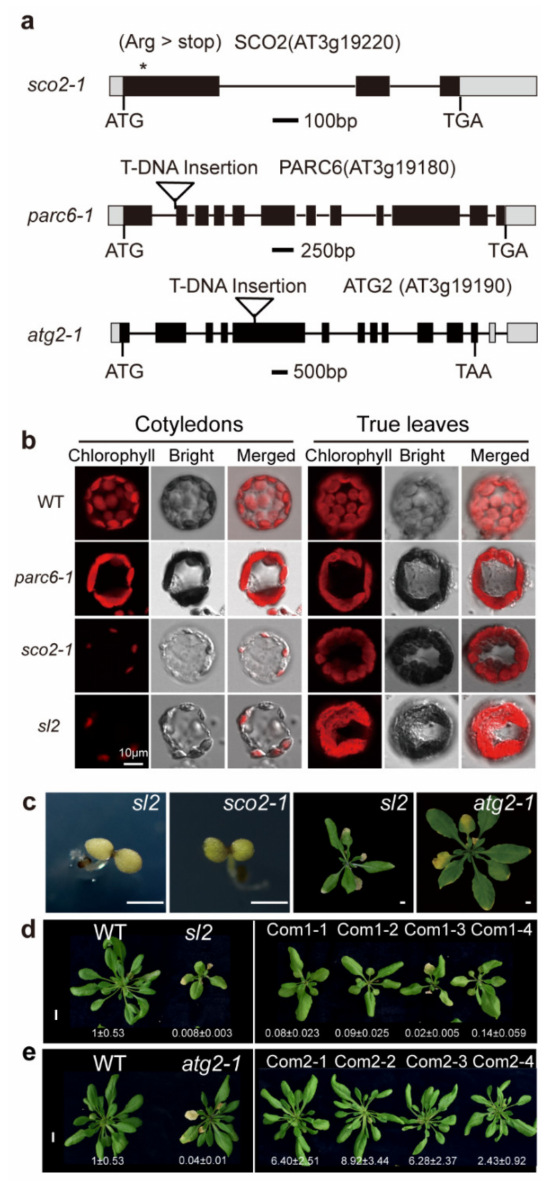
Figure 3. Identification of the corresponding genes for the mutant phenotypes. ( a ) Genomic structure models of SCO2 , PARC6 and ATG2 . Black rectangles show the open reading frame, black lines show introns, and gray rectangles show untranslated regions (UTR). Asterisks mark pointed mutation; triangles represent T-DNA insertion; ( b ) Confocal microscopy observations of chloroplasts in six-day-old cotyledons and 14-day-old true leaves; ( c ) Seven-day-old sl2 and sco2-1 mutants grown on 1 supplemented with 1% sucrose ( left ); five-week-old sl2 and atg2-1 mutants grown in soil ( right ). Bar = 25 mm; ( d ) The sl2 complementary lines expressing ATG2 cDNA driven by 35S promoter grown in soil for five weeks. The relative expression levels of ATG2 are shown under the plants. Bar = 1 cm; ( e ) The atg2-1 complementary lines expressing ATG2 cDNA driven by 35S promoter grown in soil for five weeks. The relative expression levels of ATG2 are shown under the plants. Bar = 1